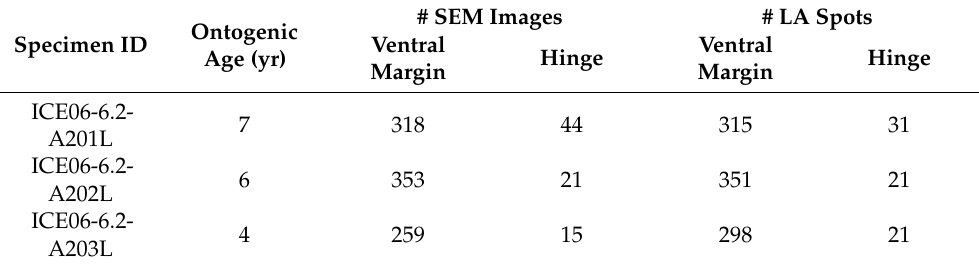
Table 1. Overview of specimens of Arctica islandica used in present study along with number of chemical analyses and areas in which microstructural analyses were conducted. Bivalves were collected alive at Þistilfjördur, NE Iceland (66 ◦ 10 (cid:48) N, 015 ◦ 21 (cid:48) W) on 17 August 2006. SEM = scanning electron microscopy; LA = laser